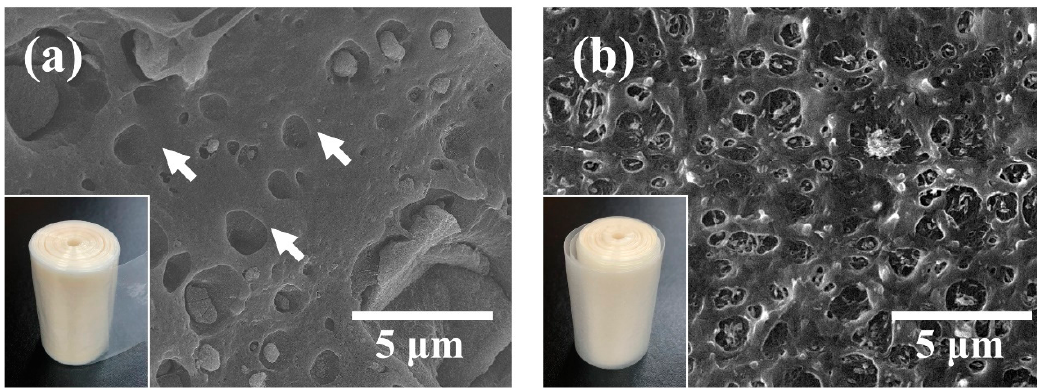
Figure 1. SEM images of cryo ‐ fractured surfaces of pristine BA/HDPE ( a ) and vBA/HDPE ( b ). The insets are digital photographs of BA/HDPE and vBA/HDPE.